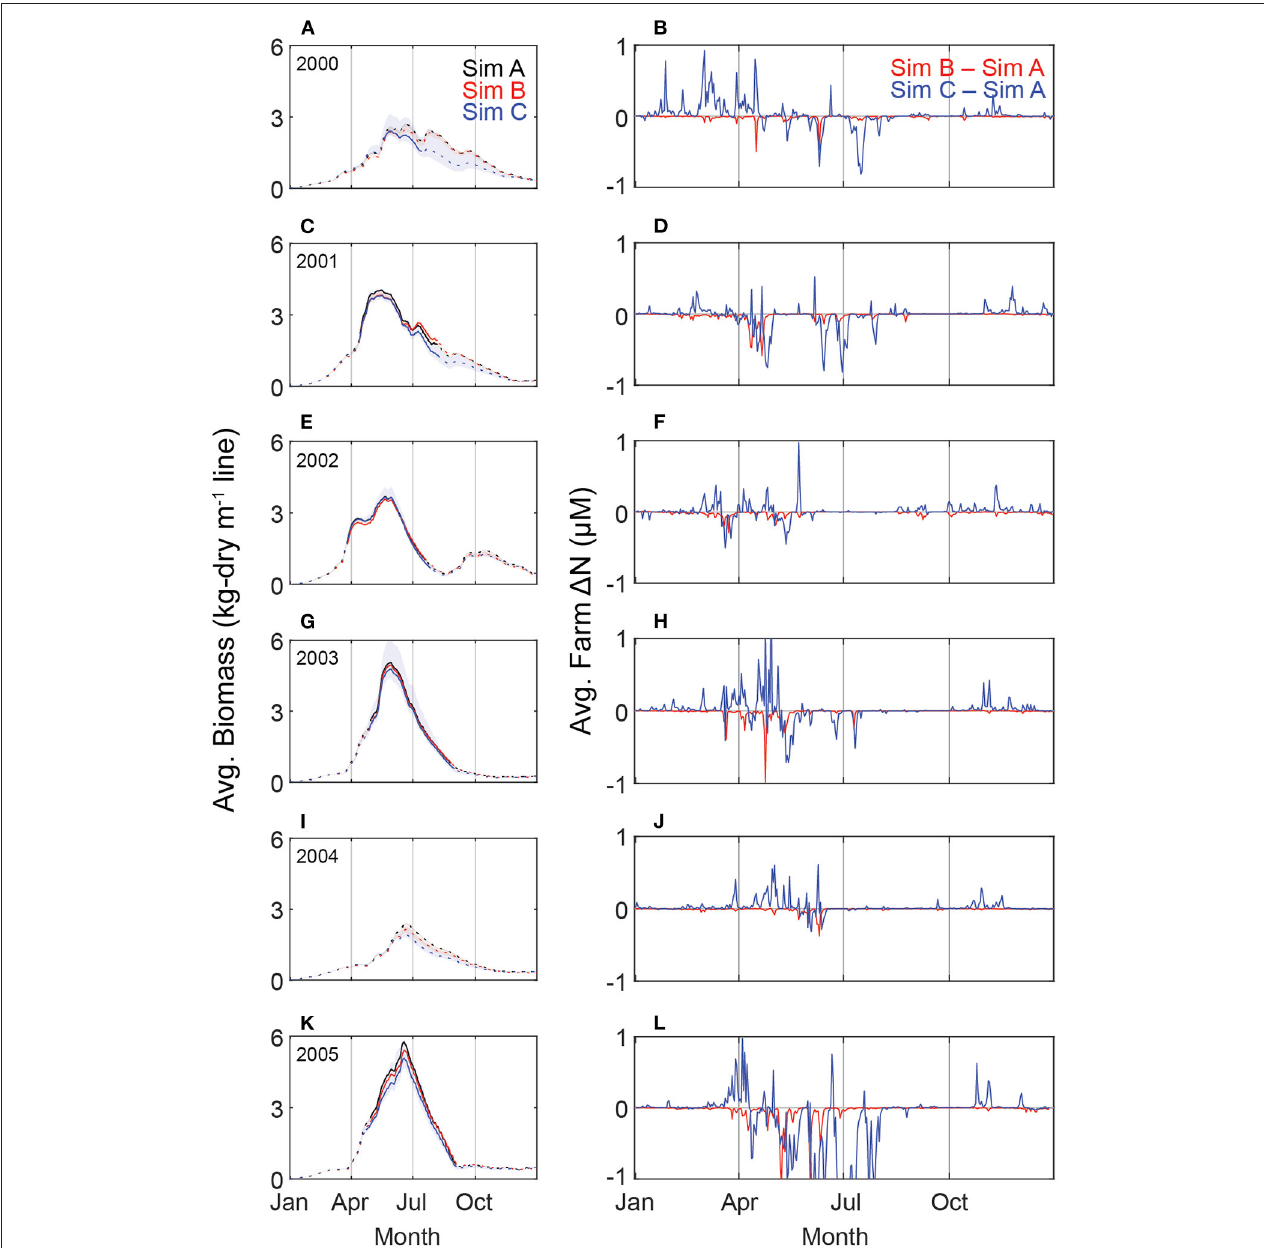
FIGURE 7 | (Left: A,C,E,G,I,K) Daily average kelp biomass (kg-dry m -1 line) for six years of simulation. Solid line indicates a formed canopy; dashed line indicates a subsurface kelp farm. Shaded regions represent the full range of biomass across the farm. Simulation A (black line) has horizontally-homogenous transport and no loss of nutrients due to kelp uptake. Simulation B (red line) has horizontally-homogeneous transport and kelp uptake effects on nutrient fields. Simulation C (blue line) includes all within-farm physics, transport, and uptake. (Right: B,D,F,H,J,L) Daily volume-averaged difference in dissolved nitrogen (NO 3 +NH 4 ) between Simulation B and Simulation A (red) and between Simulation C and Simulation A (blue). Negative values indicate lower nitrogen concentrations within the farm relative to Simulation A; positive values indicate higher nitrogen concentrations within the farm relative to Simulation A.